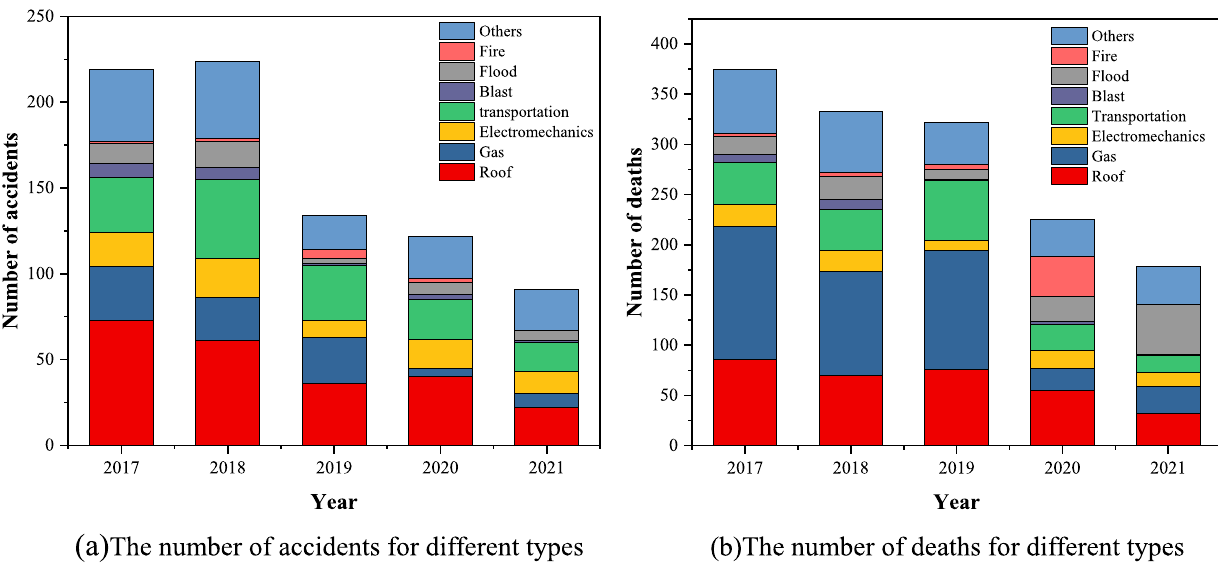
Fig. 6 Number of accidents and death tolls based on different types